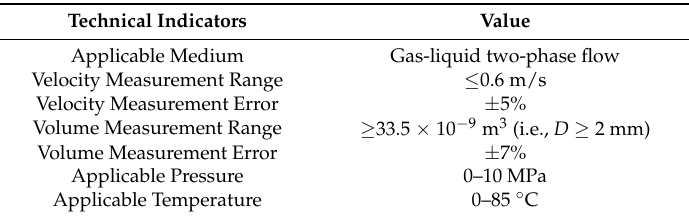
Table 3. Technical indicators of bubble